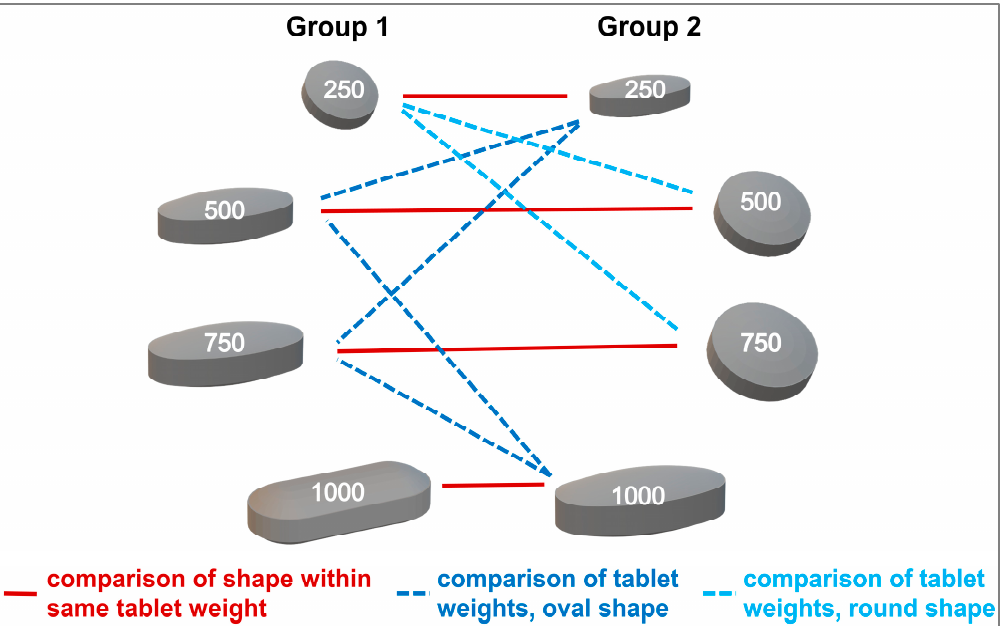
Figure 2. Comparison between tablets assigned to different experimental groups, applicable to both age categories.